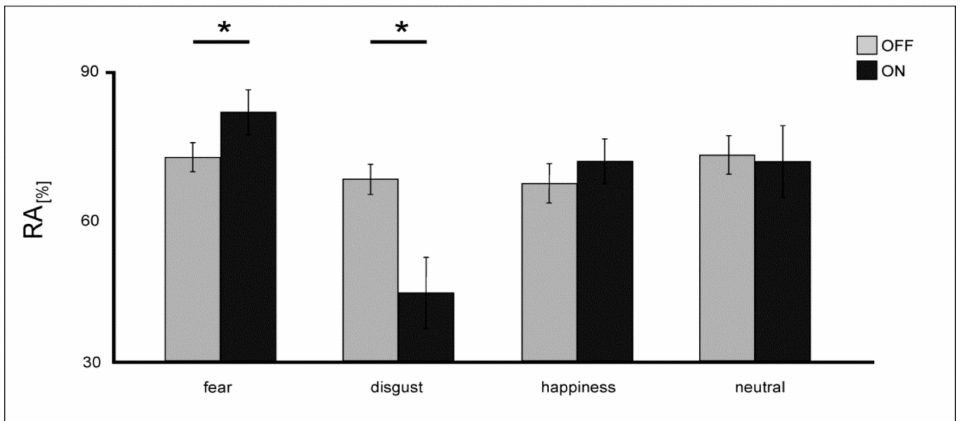
Figure 6. Mean RA values (in %) for explicit evaluation of emotional stimuli for patients under DBS (light grey) and when DBS is switched OFF (dark grey). Error bars show SE. Significant di ff erences are labeled with